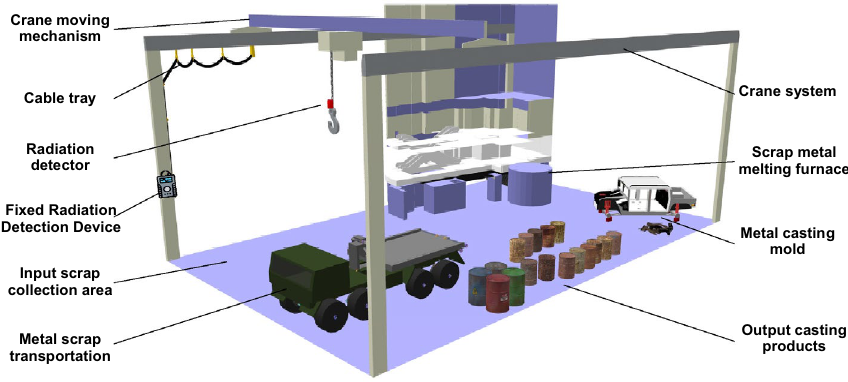
Figure 15. Diagram of the IoRSS deployment and installation in a scrap metal recycling